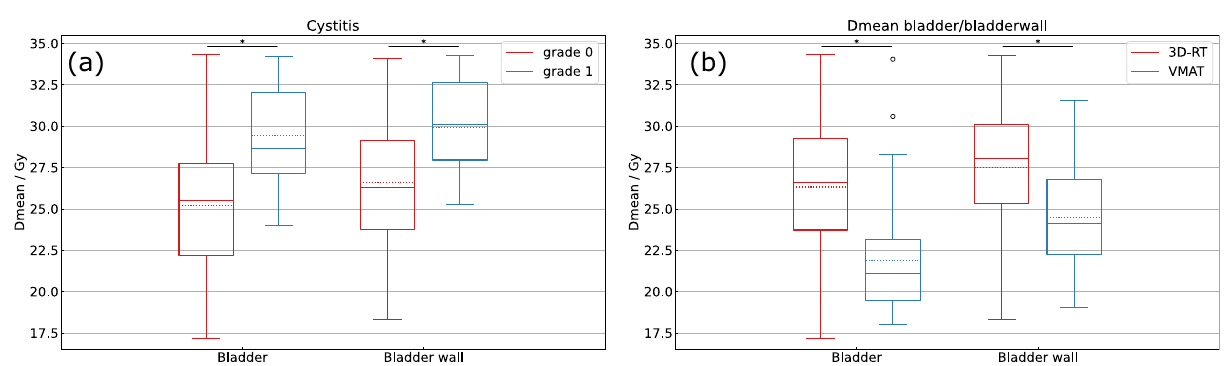
Figure 1. ( a ) Dependence of cystitis on Dmean bladder and bladder wall of all evaluated patients (n = 34) treated with 3D-conformal radiotherapy. Dose values are displayed as boxplots; box = interquartile range, solid horizontal line = median, dotted horizontal line = mean, whiskers = 1.5 × IQR. Statistical analysis was performed using t-test. A p-value < 0.05 was considered statistically significant. * = significant difference p < 0.01, Gy = Gray. ( b ) Reduction of Dmean bladder and bladder wall after volumetric modulated arc therapy (VMAT) re-planning compared to the 3D-conformal radiotherapy treatment plans. Dose values are displayed as boxplots; box = interquartile range, horizontal line = median, dotted horizontal line = mean, whiskers = 1.5 × IQR, dots = outliers. Statistical analysis was performed using Wilcoxon signed rank test. A p-value < 0.05 was considered statistically significant. * = significant difference p < 0.01, Gy = Gray, 3D-RT = 3D-conformal radiotherapy, VMAT = volumetric modulated arc